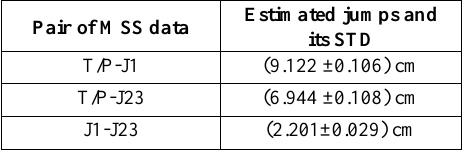
Table 5 . Jumps of MSS values given in the GDR files, computed based the time series of points over the Baltic Sea. In column 1 of Fig. 3 we have offered the value of jumps shows of the MSS values in time series of four points over of Baltic Table 4 . MSS models used in different GDR file versions of Sea. Column 2 and 3 of this figure shows the MSS values at TOPEX/Poseidon, Jason-1, 2, and 3 missions. these four points as given by the GDR files, before and after removal of the offsets, column 2 and 3, According to Table 4, different MSS models have been used by different missions. The aim of this work is to compare these